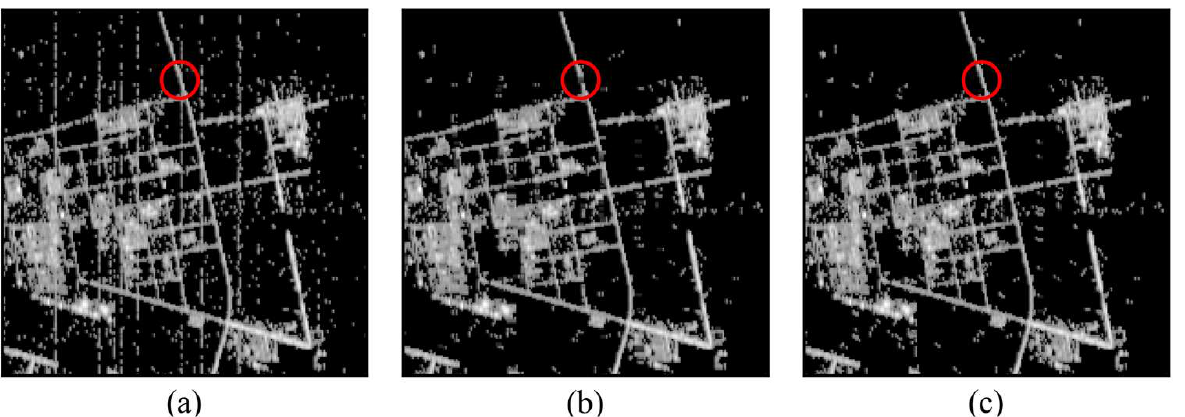
Figure 12. Comparison of different stripes restore methods. ( a ) Original image. ( b ) The neighborhood averaging method. ( c ) The method based on spectral similarity. ( a – c ) The red circle emphasizes the effect of different stripes restore methods.